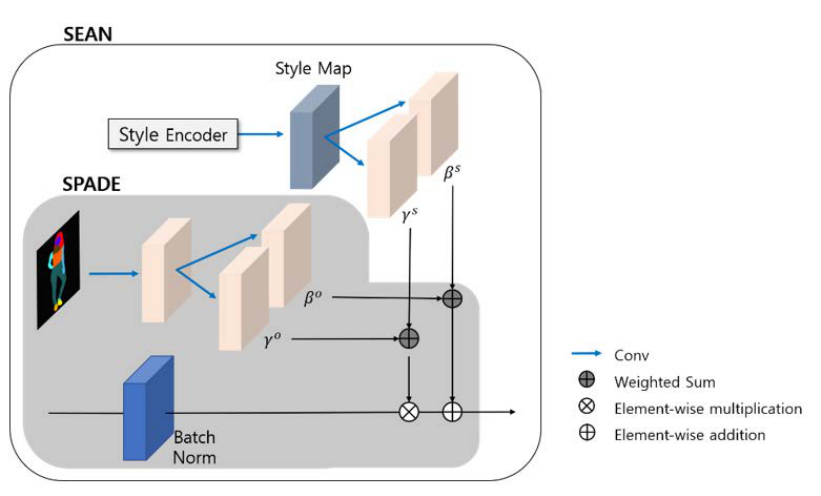
Figure 5. Structure of semantic region-adaptive normalization